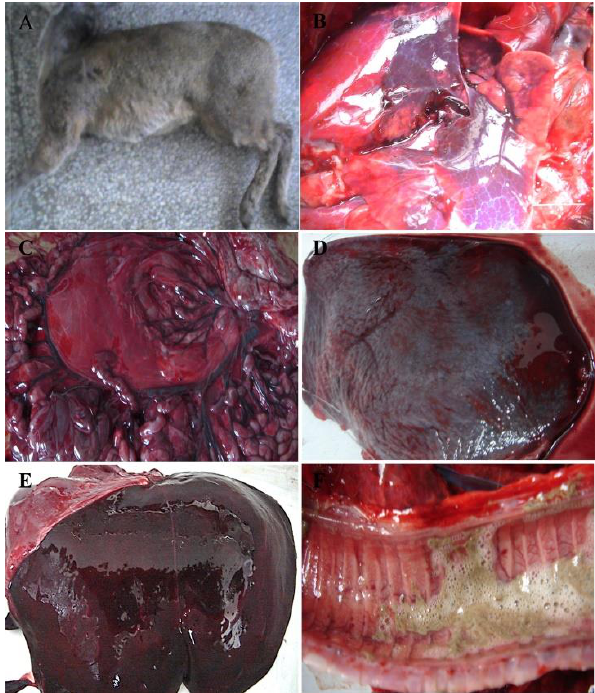
Figure 1. Macroscopic lesions observed in diseased Alpine musk deer. A dead Alpine musk deer ( A ) and common signs of hyperemia, hemorrhage, and necrosis observed in the lung ( B ), stomach and intestine ( C ), spleen ( D ), liver ( E ), and trachea ( F ).